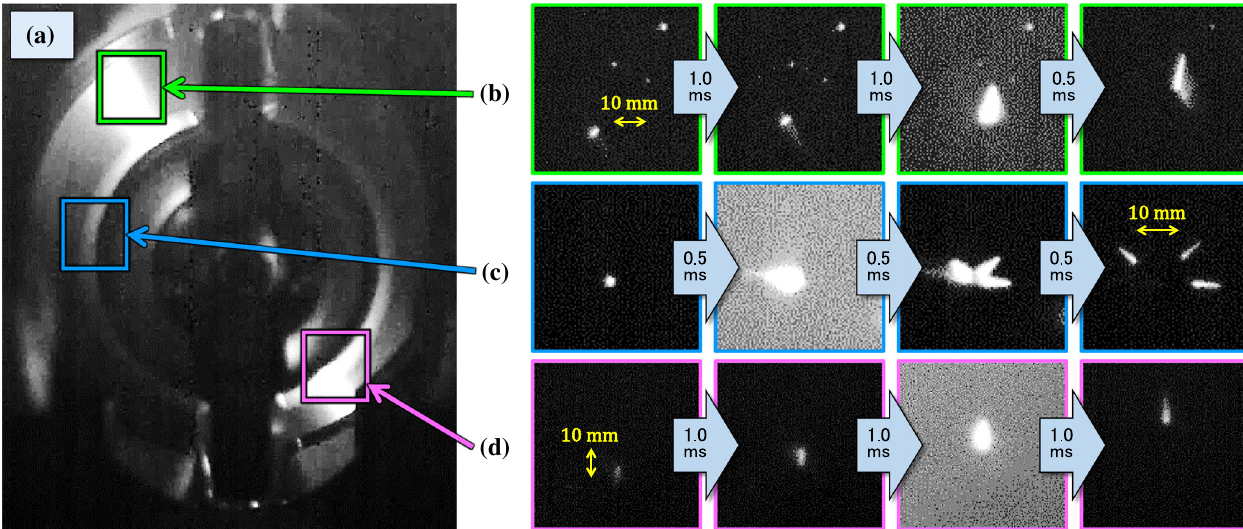
FIG. 20. Three other breakdown events accompanied by a flying bright object. The brightness and contrast of all of the images were enhanced by 60% and 40% relative to the original brightness and contrast, respectively. (a) Photograph showing the view of the high- speed camera directed toward the downstream end plate with light injected into the cavity for visualization. Snapshots of the (b) second, (c) third, and (d) fourth breakdown events around the time of cavity breakdown. These are magnified views of the regions shown with (b) green, (c) blue, and (d) magenta squares in (a). These breakdown events occurred in 2017 at (b) V c ¼ 0 . 89 MV, 12 ∶ 14 on March 21,